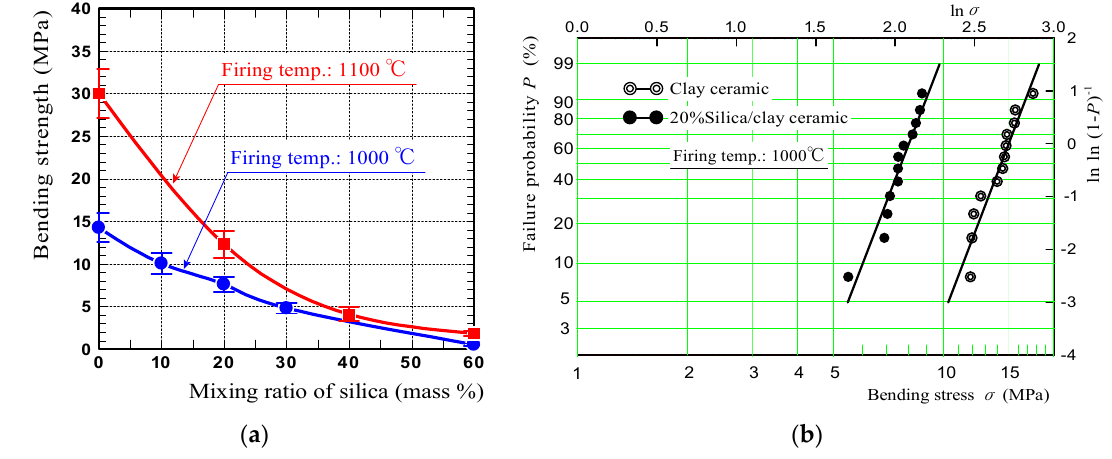
Figure 5. ( a ) The bending strengths of silica/clay ceramics and ( b ) Weibull plots of the bending strengths of 20% silica/clay and clay ceramics.